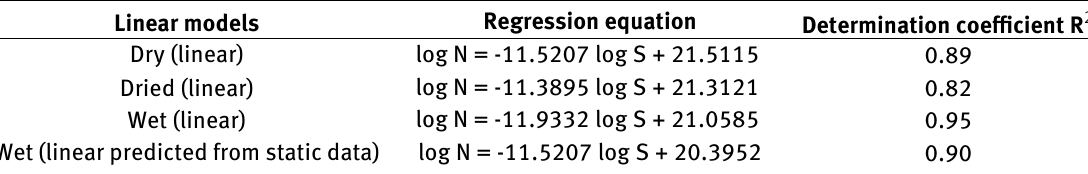
Table 2: Linear regression of fatigue data. Linear models